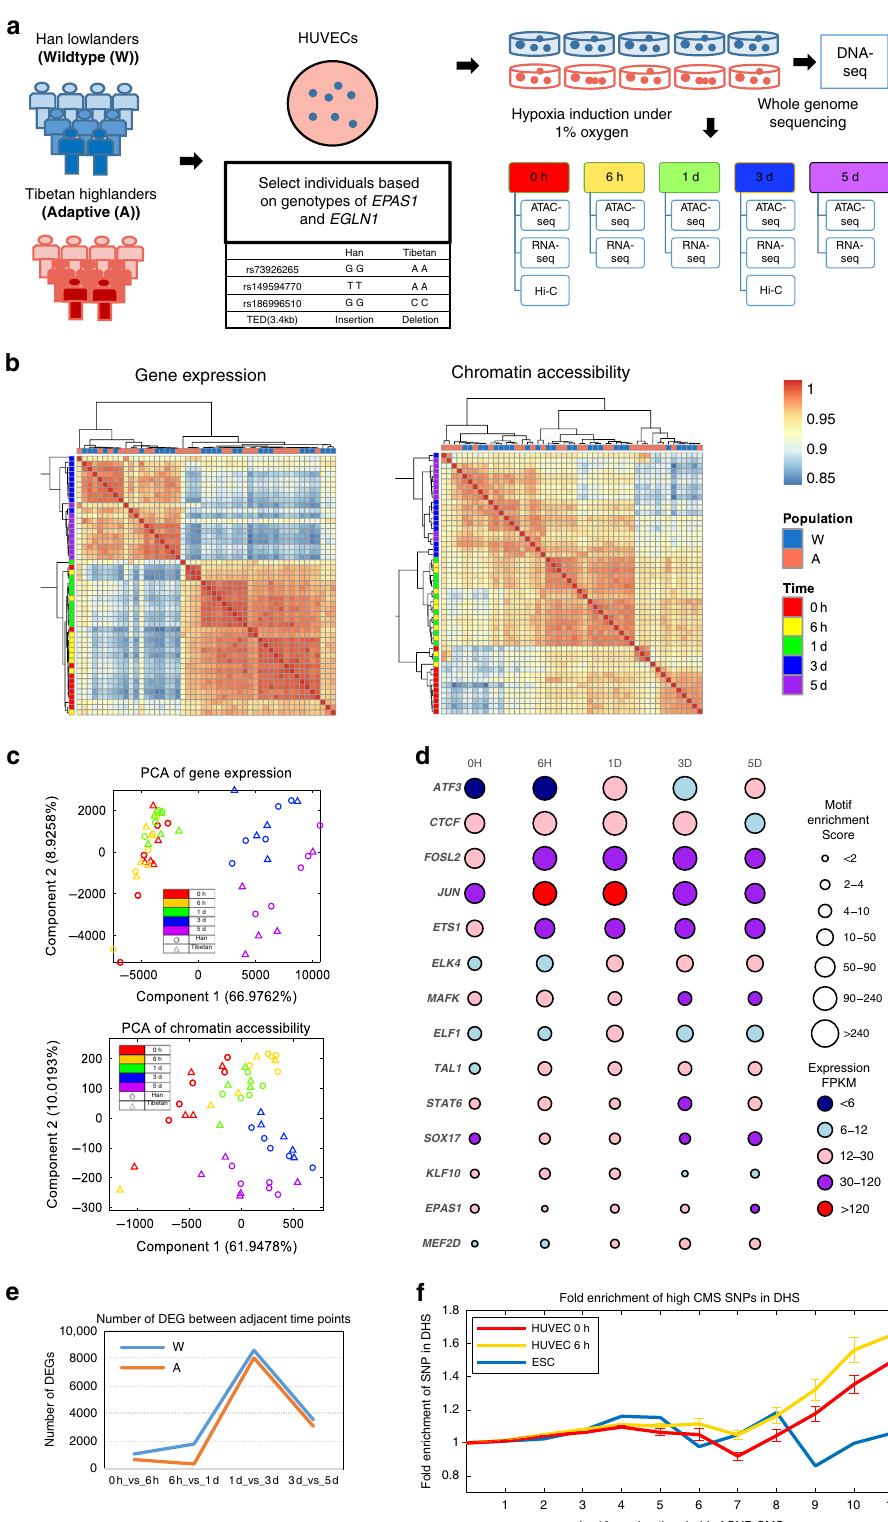
enrichment compared with a large panel of cell types from ROADMAP (Supplementary Fig.